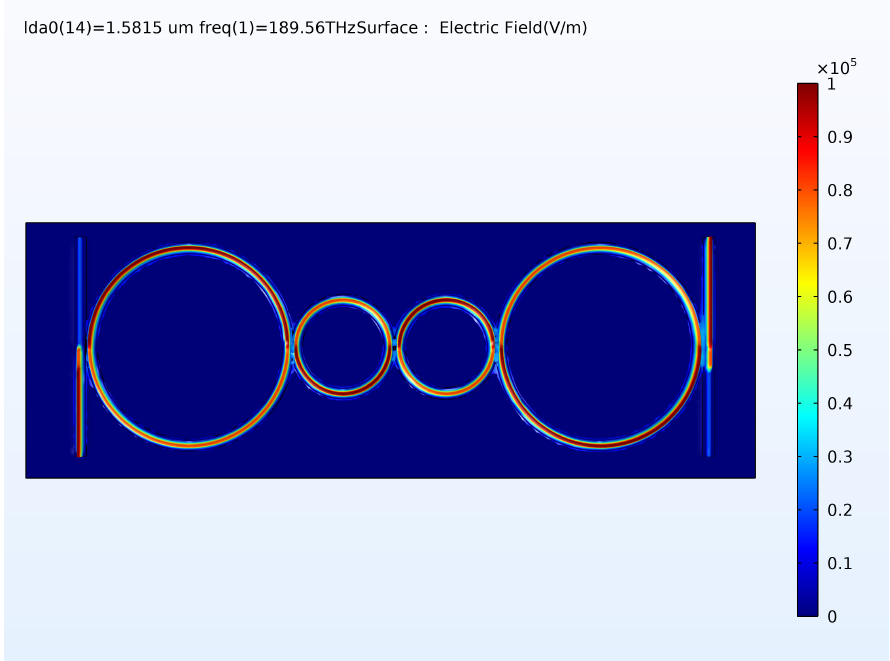
Figure 10. TE mode Electric field distribution in the filter structure around the resonance wavelength (1581.5